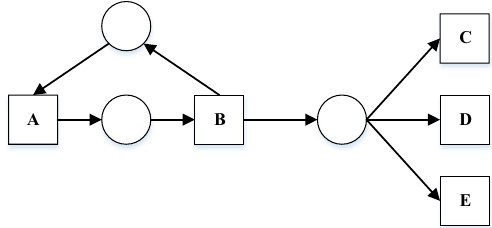
Fig. 4 The result of position